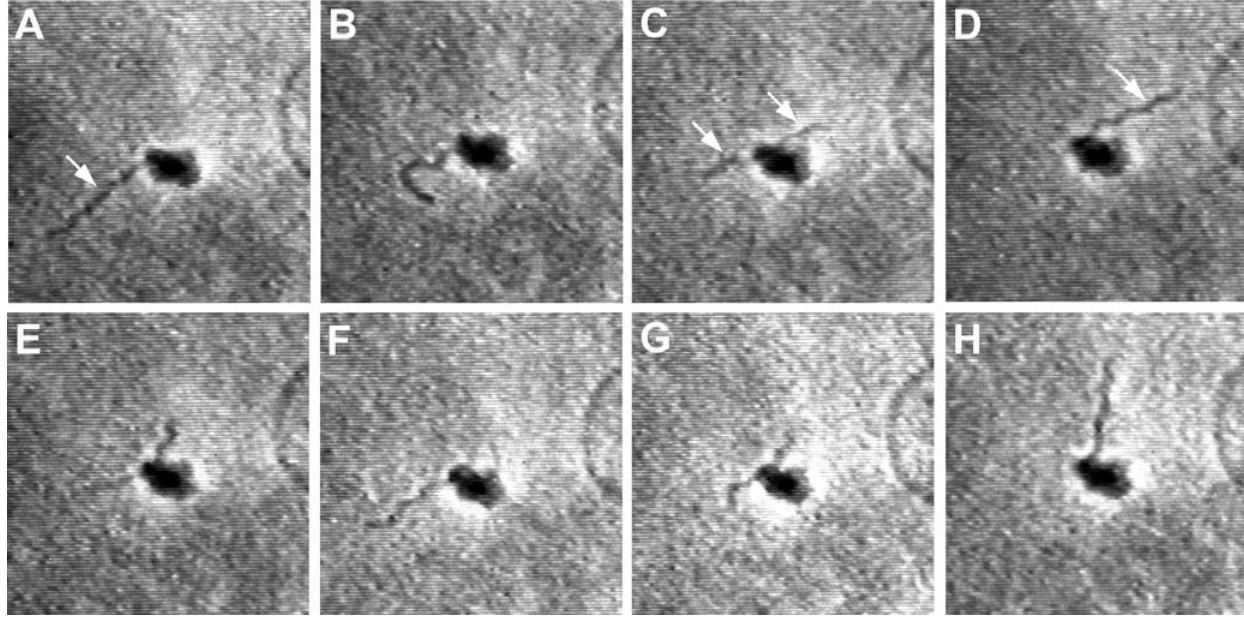
Figure 1. Sequential translocations of Bb across a platelet (see text). Total elapsed time, A-H: 9 sec. Measured crossing speeds were as fast as 2800 m m/min, upward of two orders of magni-tude above the speed of a human neutrophil, the fastest cell in the body. Images from real-time phase-contrast videomicroscopy. Approx. 6 1,000.